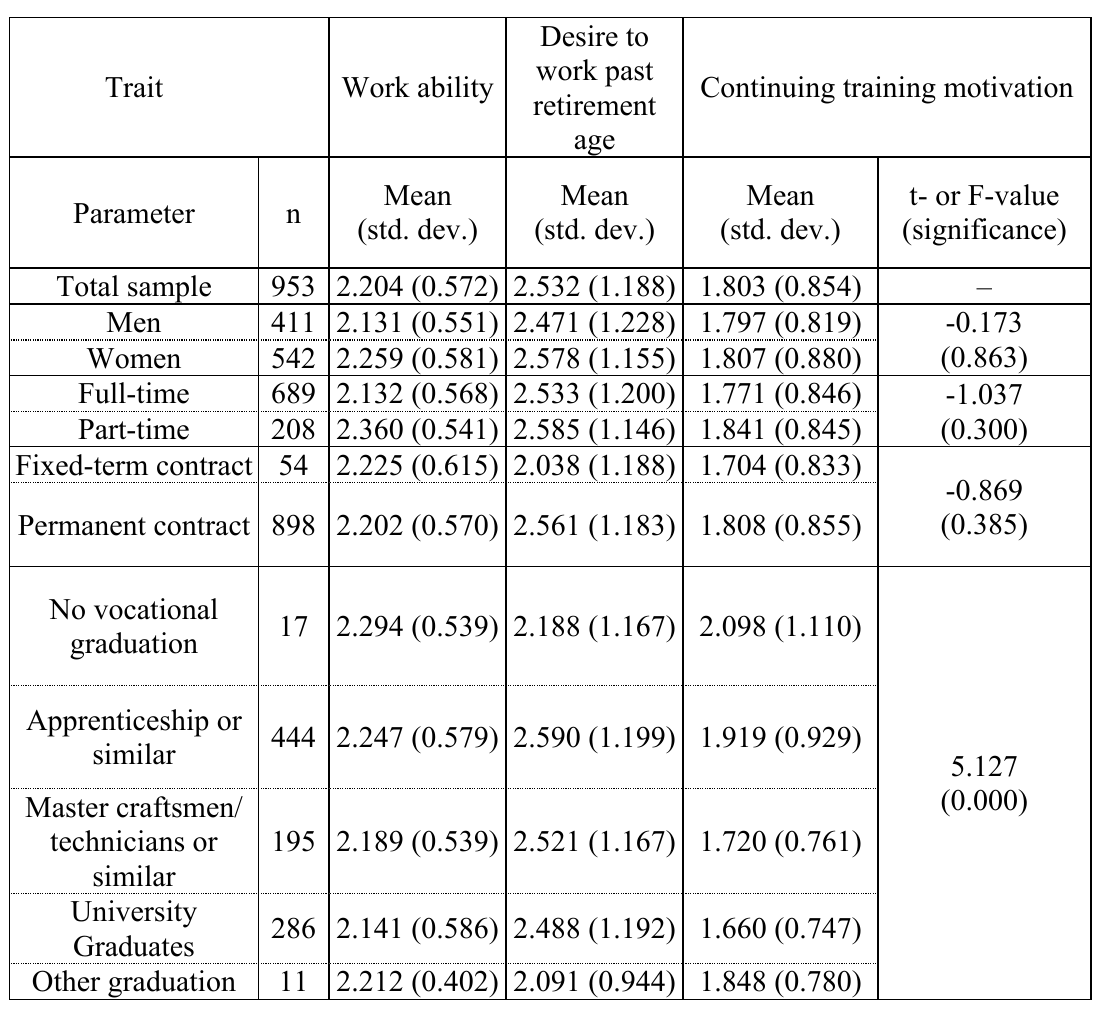
Table 1 . Main results differentiated for selected respondent